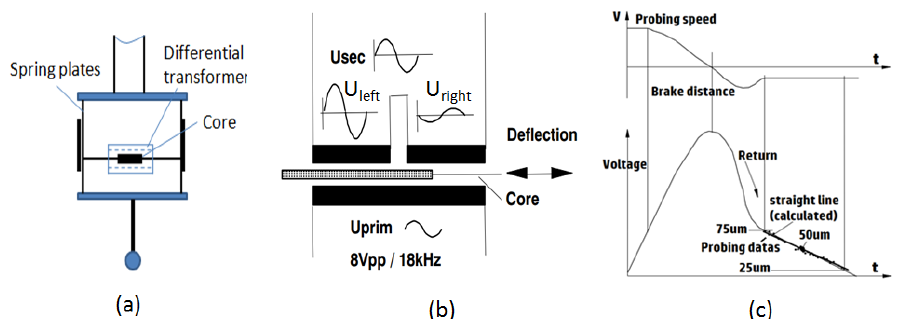
Figure 4. Measuring principle diagram of precision displacement probe for Coordinate Measuring Machine (CMM). ( a ) Mechanical schematic diagram of the CMM probe; ( b ) circuit schematic diagram of the CMM probe; ( c ) schematic diagram of the voltage of the probe signal changing with time during the contact measurement of the probe.